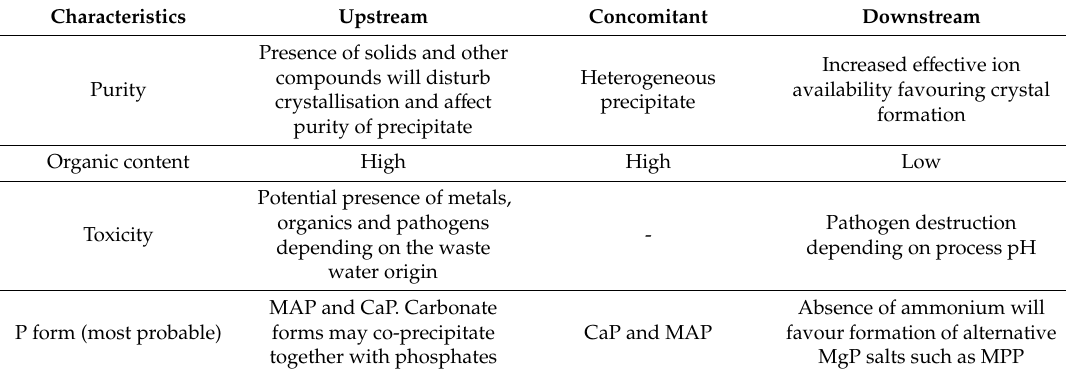
Table 5. Major expected characteristics for the recovered precipitated phosphate salts depending on the production process configuration (upstream, concomitant and downstream